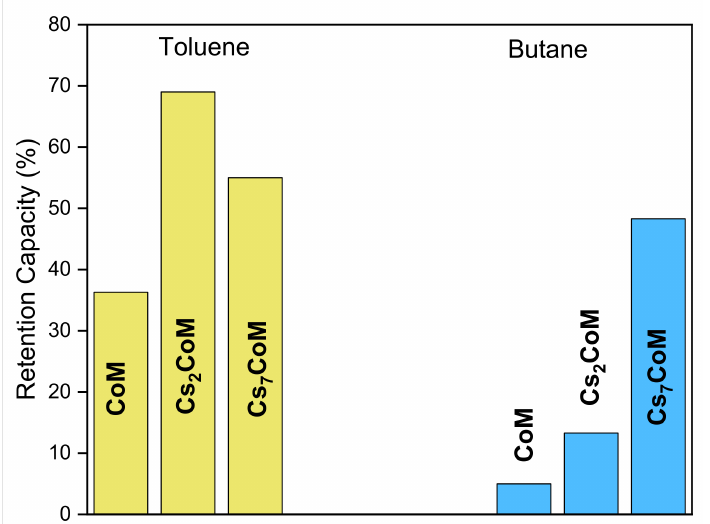
Figure 8. Toluene and butane retention capacity for hydrocarbon mixture adsorption on monolithic CoM and Cs x CoM